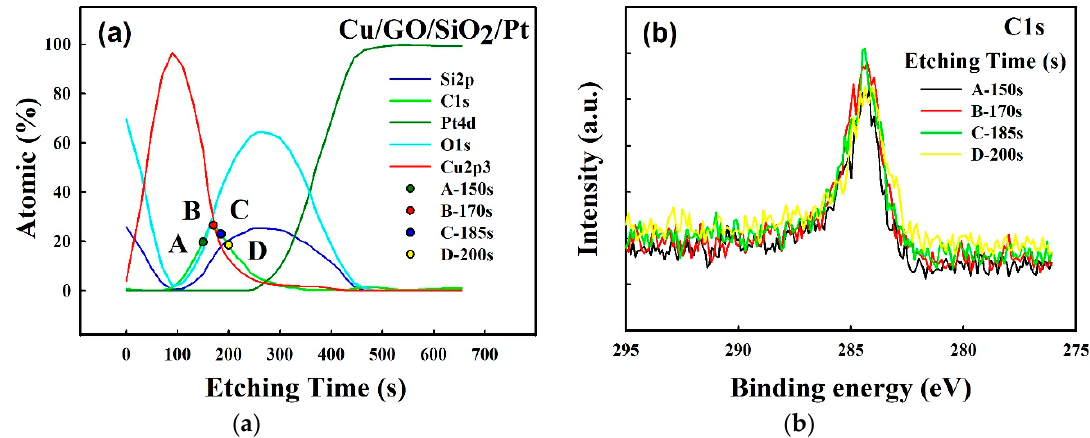
Figure 2. ( a ) XPS depth profile of the Cu/GO/SiO 2 /Pt structure. ( b ) C1s XPS spectra of the GO layer between the Cu and SiO 2